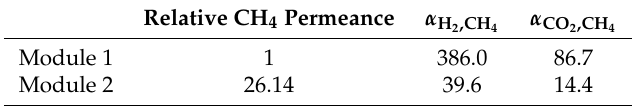
Table 3. Relative permeance and ideal selectivities for used membrane modules 1